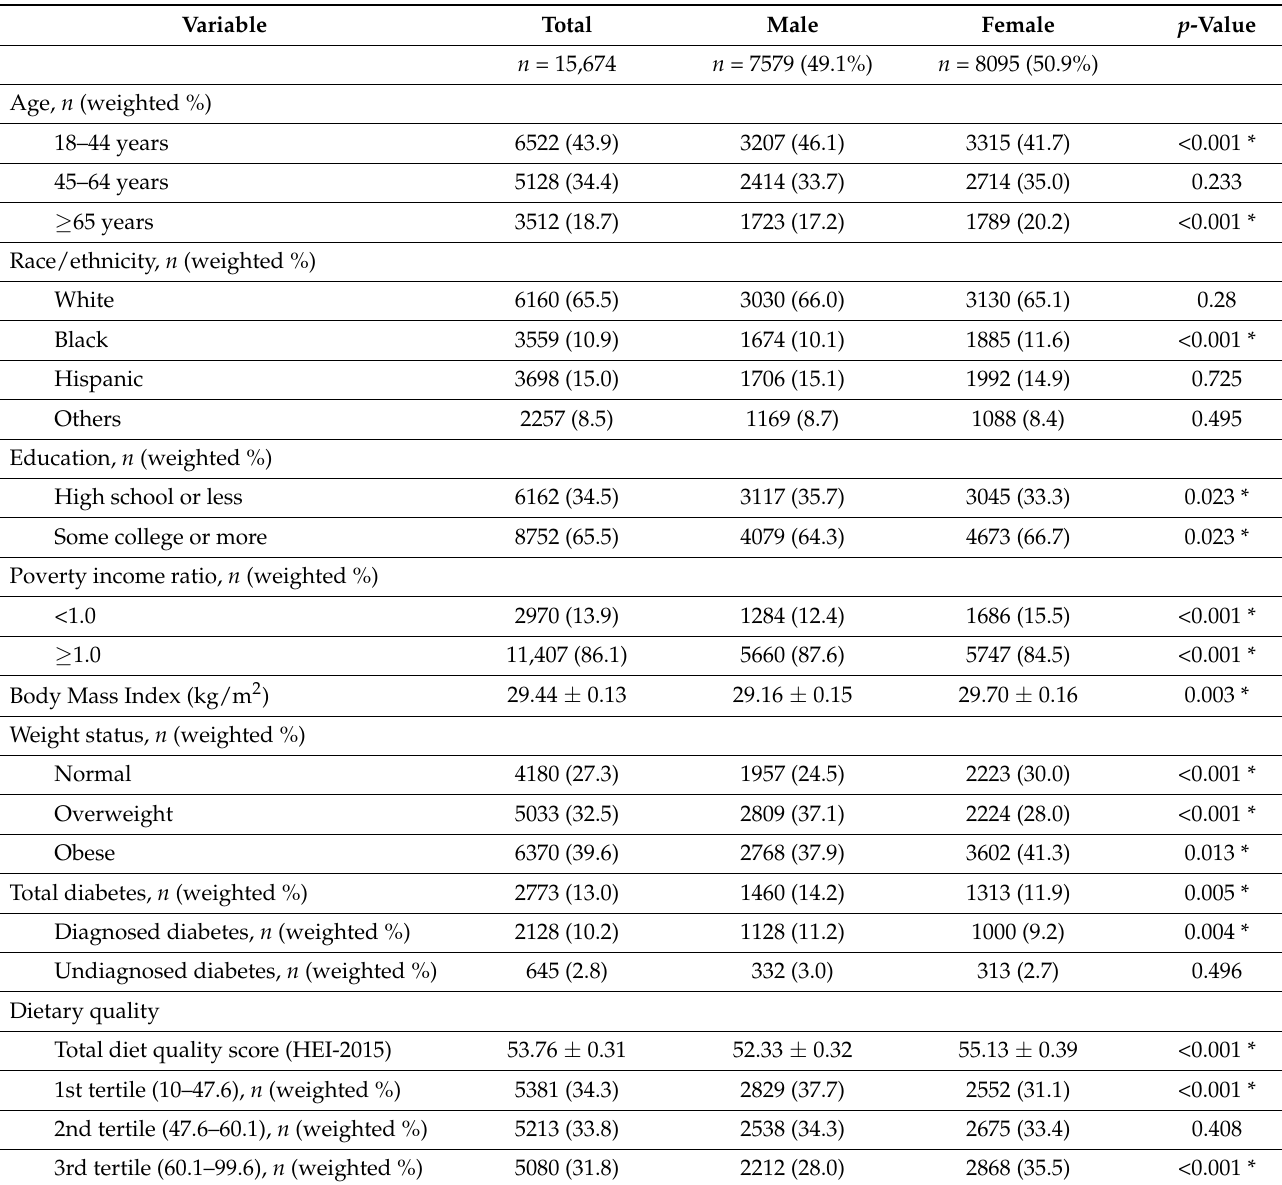
Table 1. Demographic characteristics stratified by sex ( n =